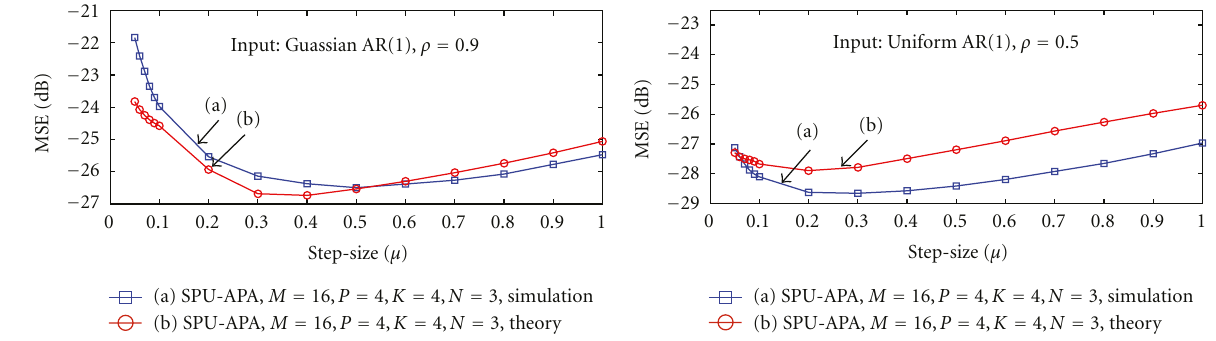
Figure 18: Steady-state MSE of SPU-APA with M = 16, P = 4, K = 4, and N = 3 as a function of the step size in nonstationary environment for di ff erent input signals.